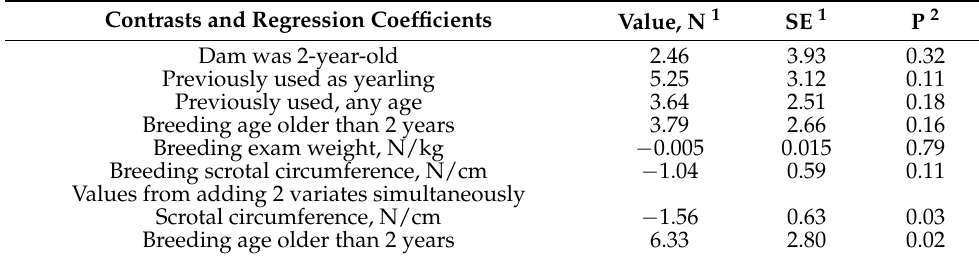
Table 5. Patterns of edited bull usage by calf birth